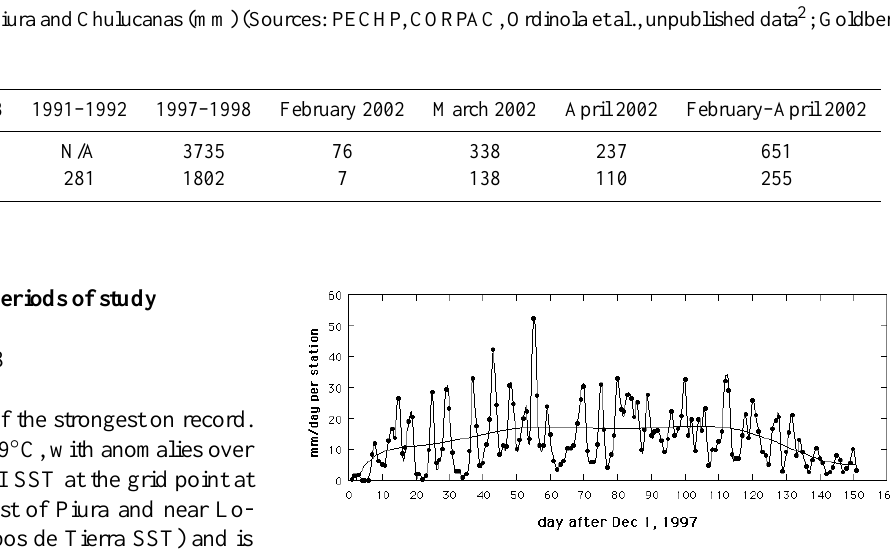
Fig. 3. Daily mean rainfall (mm) for all stations in northwestern Peru during period 1 December 1997–30 April 1998. Smoothed curve suggests seasonal evolution. From Douglas et al.